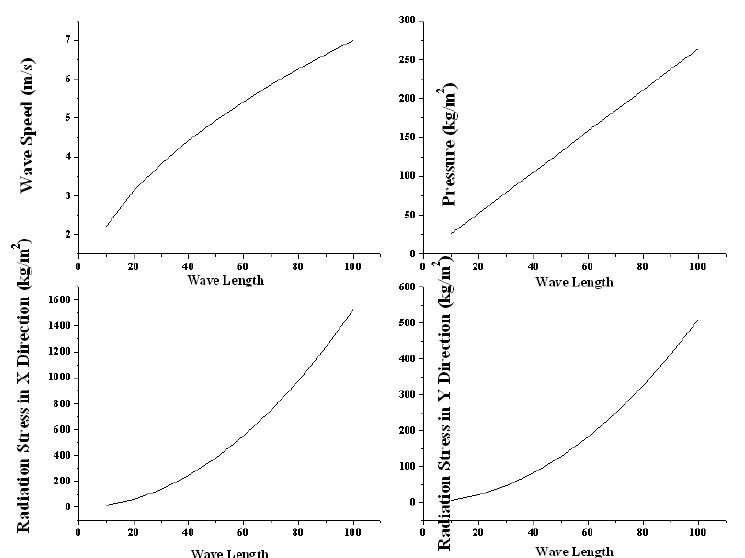
Figure 1: Mathematical characteristics of wave in shallow water.